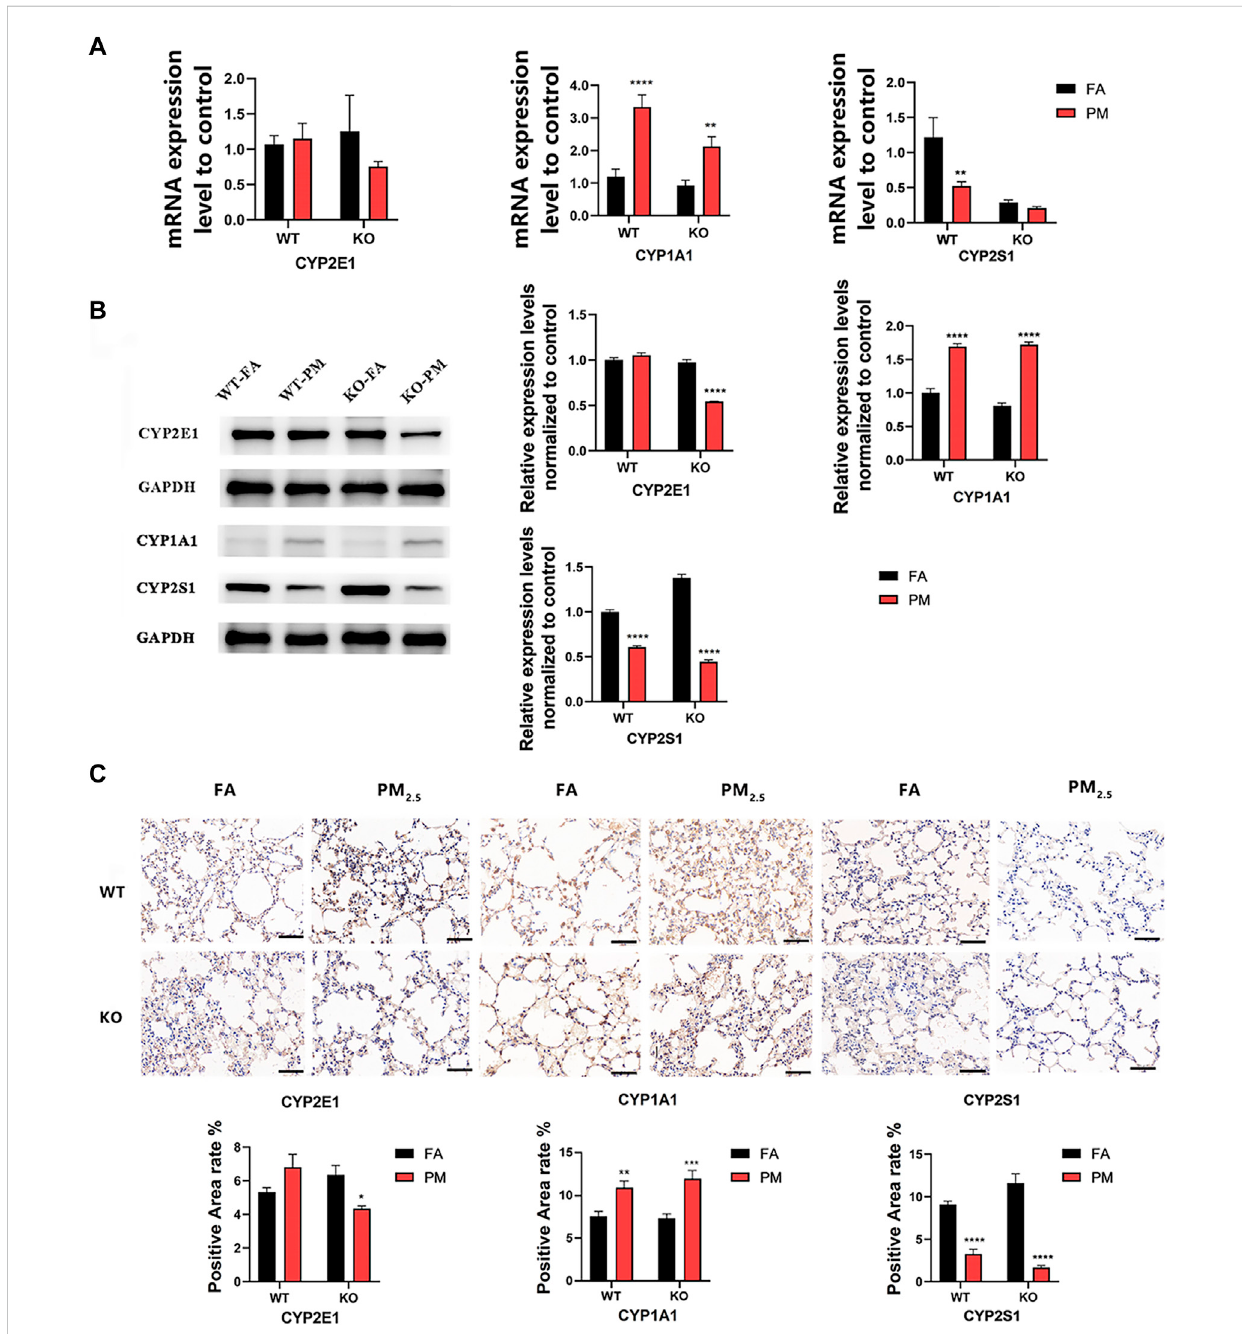
Expression levels of CYP450 enzyme in WT group and Nrf2 − / − group. (A) Changes in mRNA levels of CYP450 enzyme. (B) The expression of CYP450 enzyme protein levels was analyzed by WB and quanti fi ed by ImageJ analysis. n = 3 per group. (C) Immunohistochemical detection of CYP450 protein expression in four groups and quantitative analysis of the positive area. n = 2 per group. Scale bars are 50 μ m, FA, fi ltered air; PM, fi ne particulate matter. WT, wild-type mice; KO, Nrf2 − / − mice. Error bars represent mean ± SEM, * p < 0.05, ** p < 0.01, *** p < 0.001, **** p <